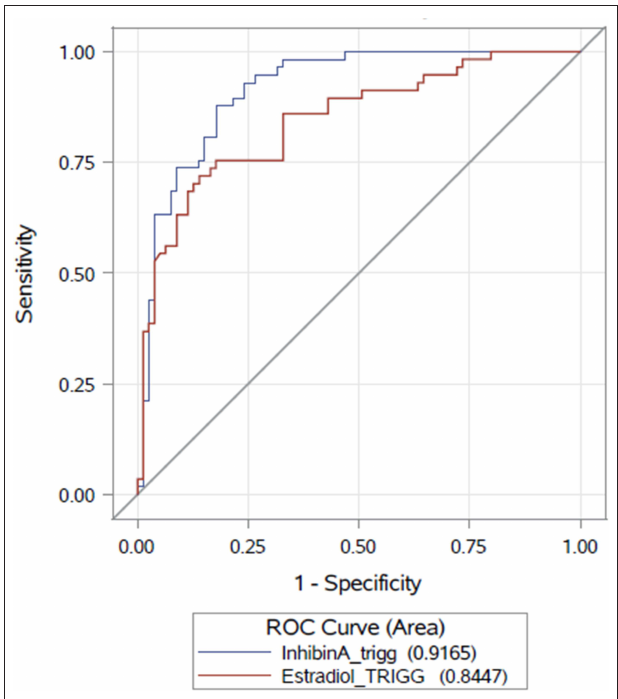
FIGURE 2 | Correlations between Inhibin A/E2 and number of retrieved/mature oocytes as scatter